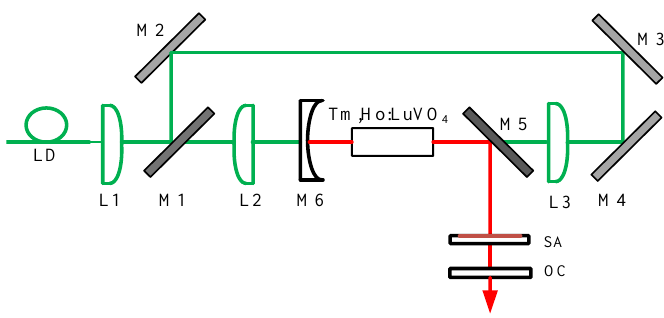
Figure 1. Experimental setup of the passively Q-switched Tm,Ho:LuVO 4 laser.